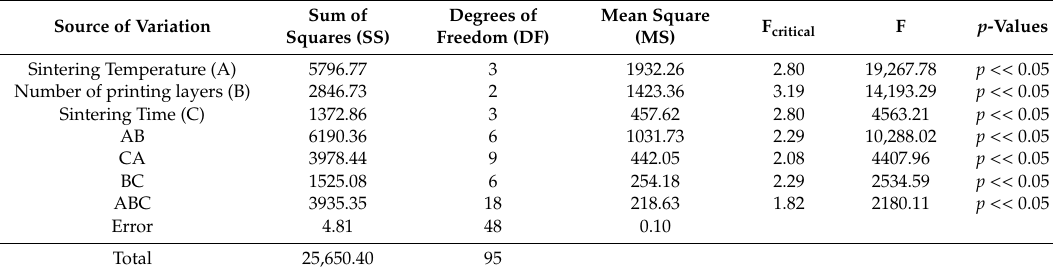
Table 4. Analysis of Variance (ANOVA)